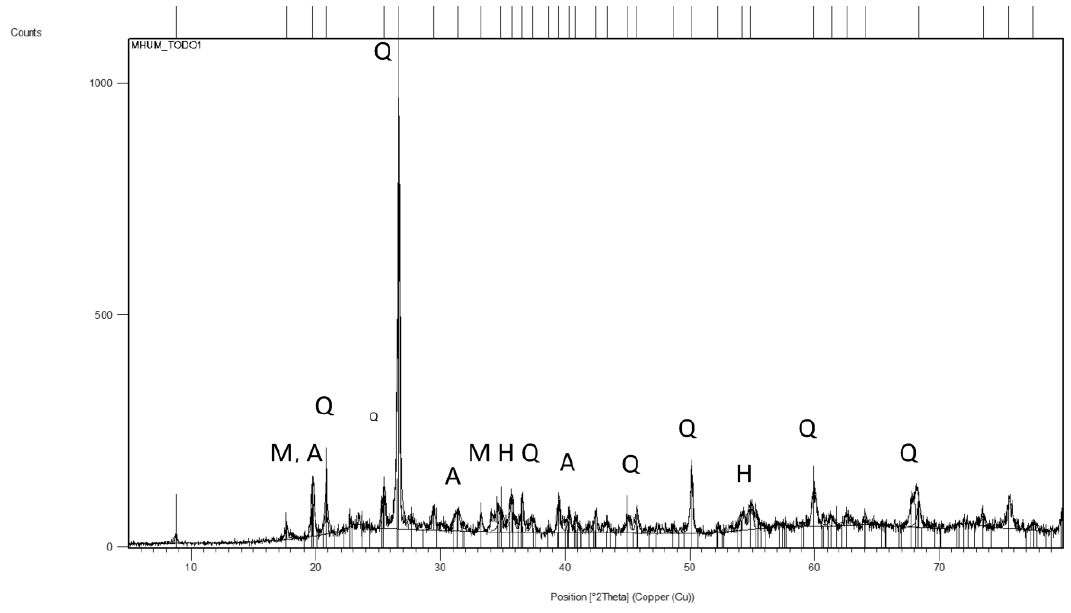
Figure 1. X-ray diffraction pattern of the bottom ash: M, Muscovite; A, Anhydrite; Q, Quartz; and H, Hematite.